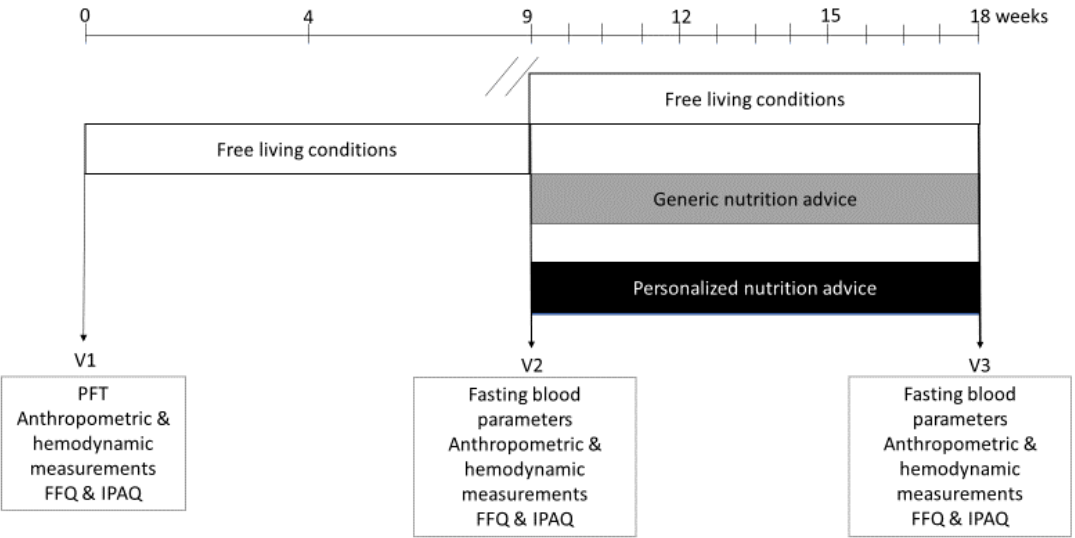
Figure 1. Study design. V1, V2, V3 represent the visit day numbers that the participants had their test day in the metabolic ward (Biofortis, France). Between Visits 1 and 2, the free-living period was at least nine weeks. All participants started their treatment after Visit 2 for nine weeks. Visit 3 was the last test day. FFQ—food frequency questionnaire; IPAQ—international physical activity questionnaire; PFT—PhenFlex challenge